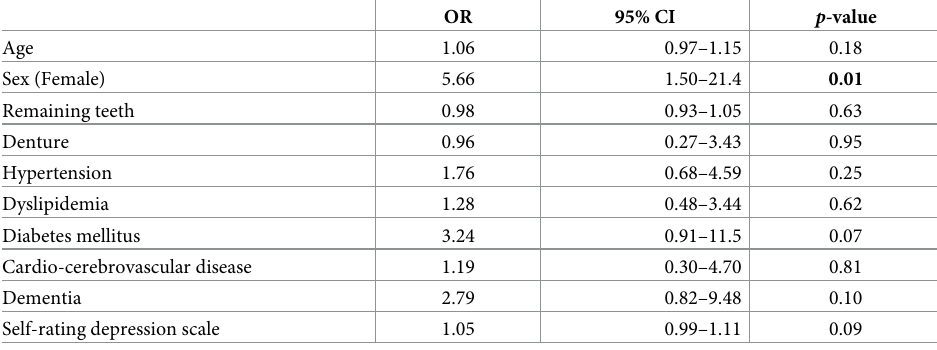
Table 5. Multivariate logistic regression analysis between pre-sarcopenia (0) and sarcopenia (1) (n =